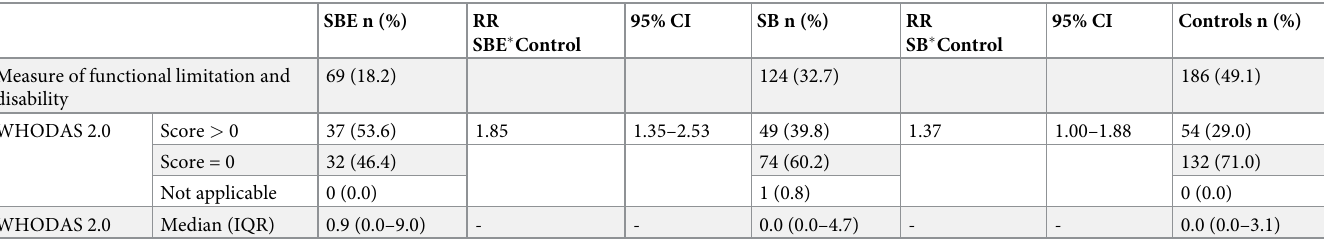
Table 2. WHODAS 2.0 assessment of the study participants.